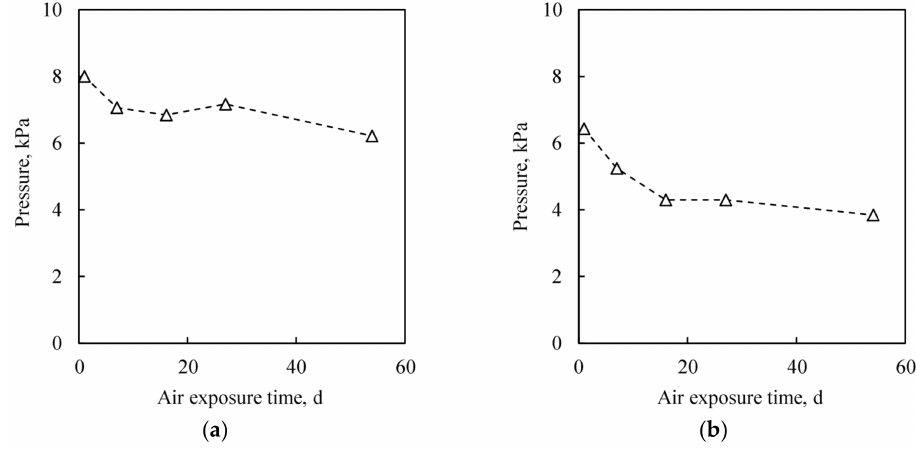
Figure 8. Cavity pressure change with air exposure time. ( a ) Citric acid treated wafer, which was